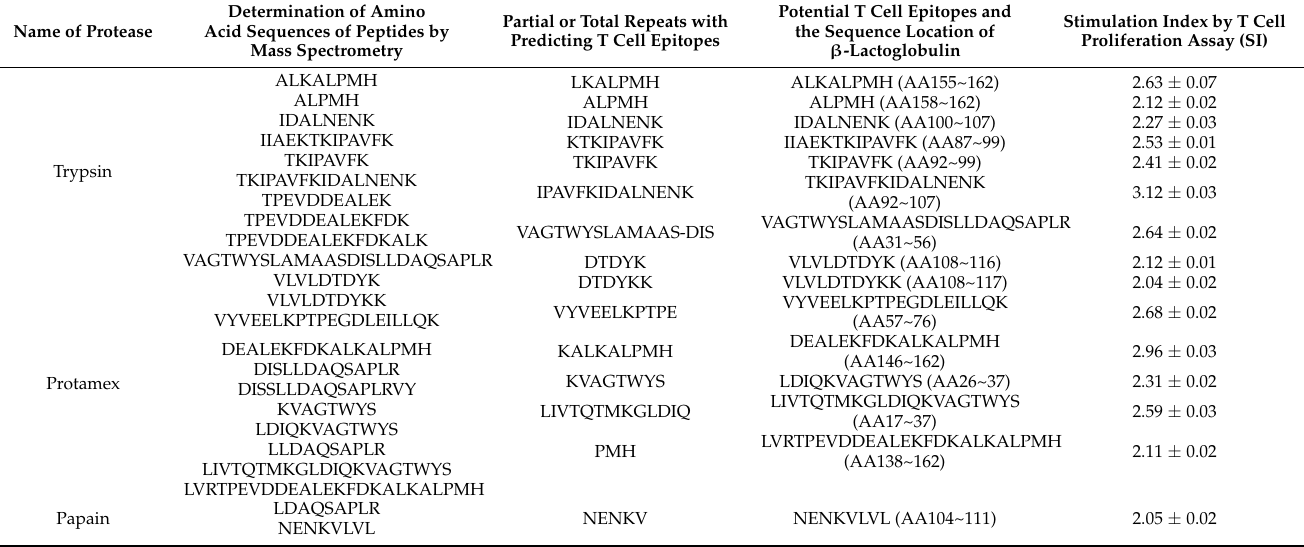
Table 1. Amino acid sequence of β -lactoglobulin hydrolysate peptides and identification of T cell